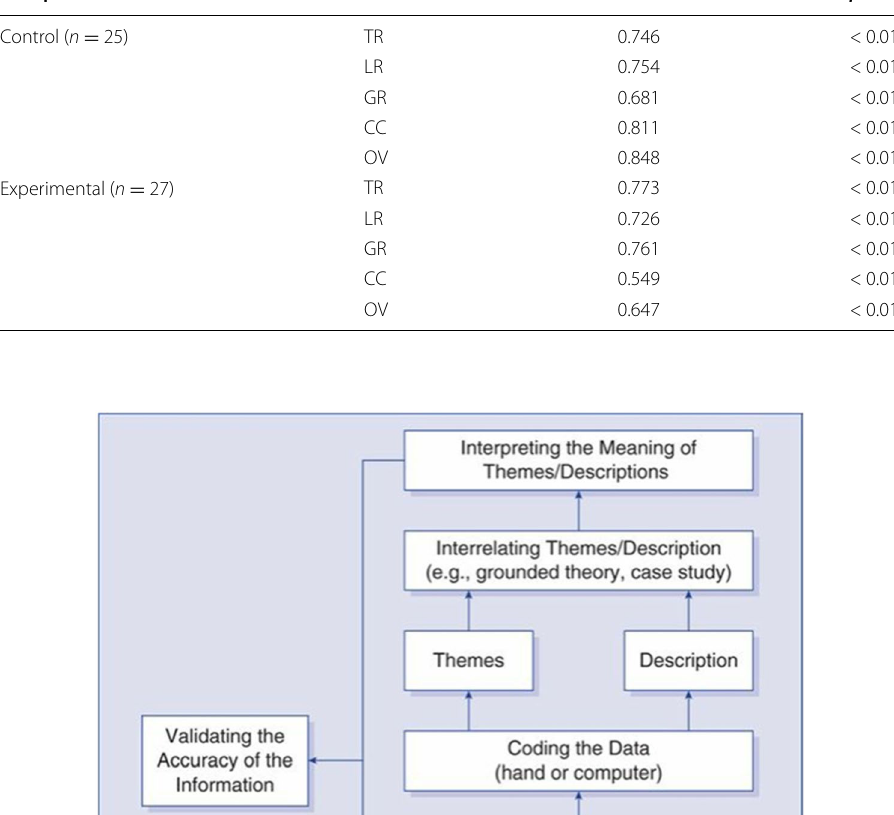
Table 3 Distribution of data of the posttest Group Criteria